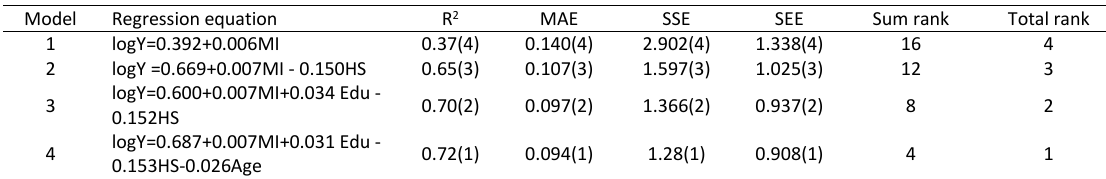
Table 7: Selection of best-fitted multiple linear regression model